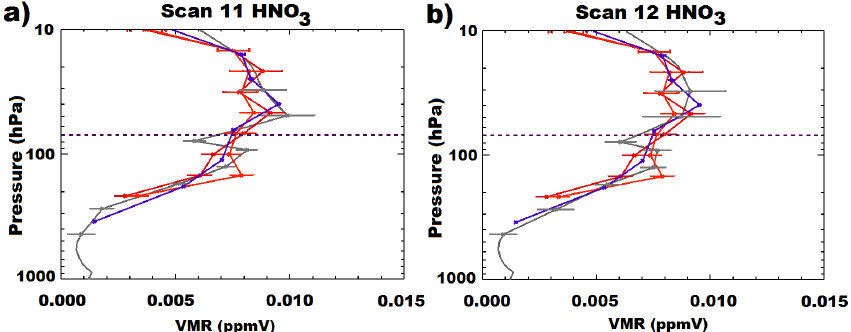
Fig. 11. Comparison of HNO 3 profiles retrieved from MARSCHALS scans 11 and 12 (grey) with MIPAS/ENVISAT (blue) and MLS/Aura (red) HNO 3 profiles. The horizontal dashed line represents the flight altitude level.